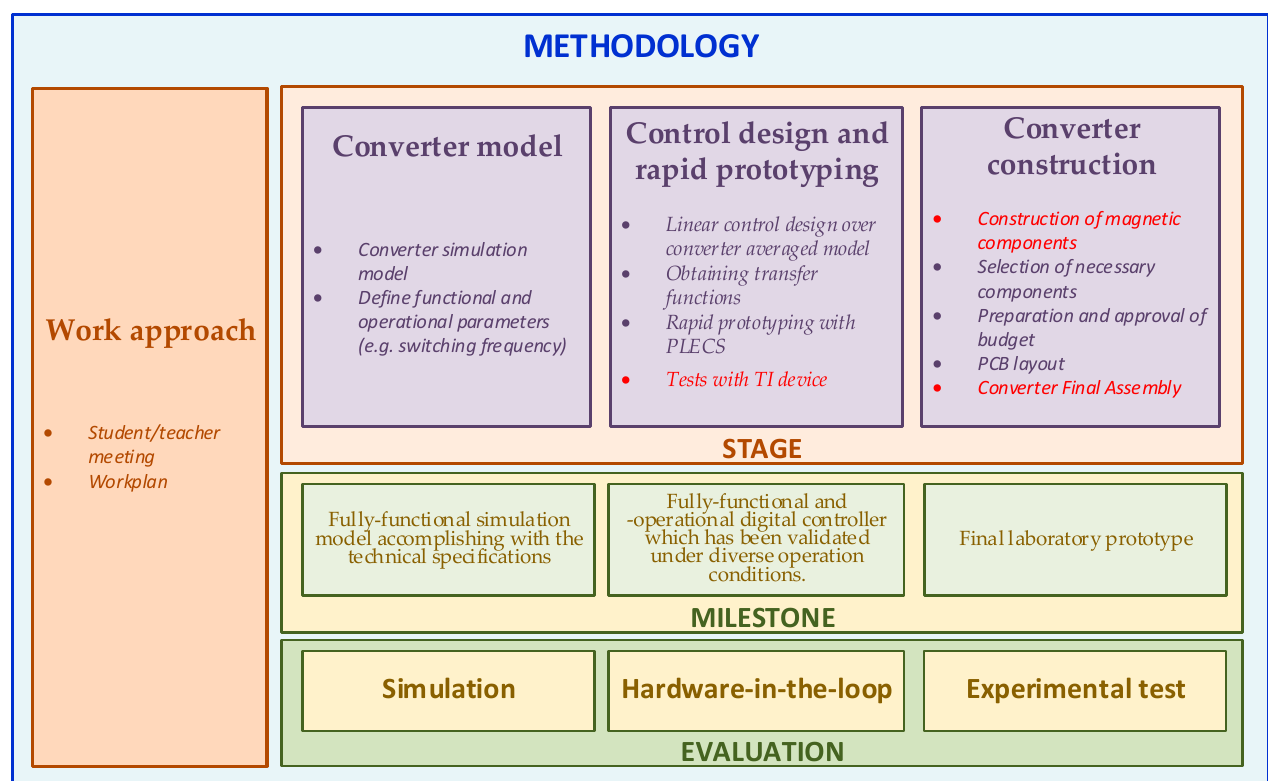
Figure 1. Methodology and proposed tasks.